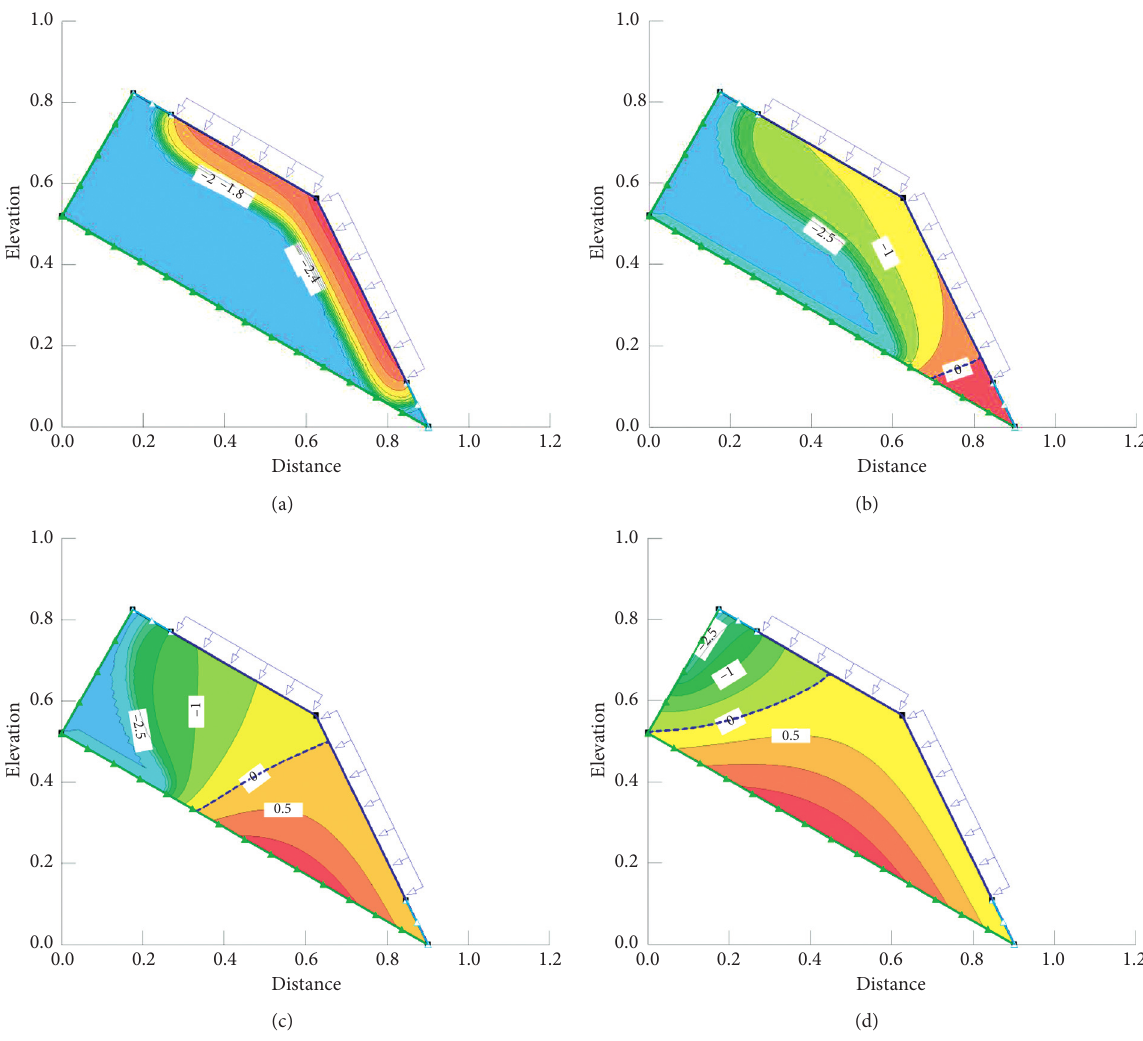
Figure 7: Seepage flow modeling results corresponding to elapsed times of (a) 30 min; (b) 60 min; (c) 128min (at 4th failure); (d) 239min (at 5th